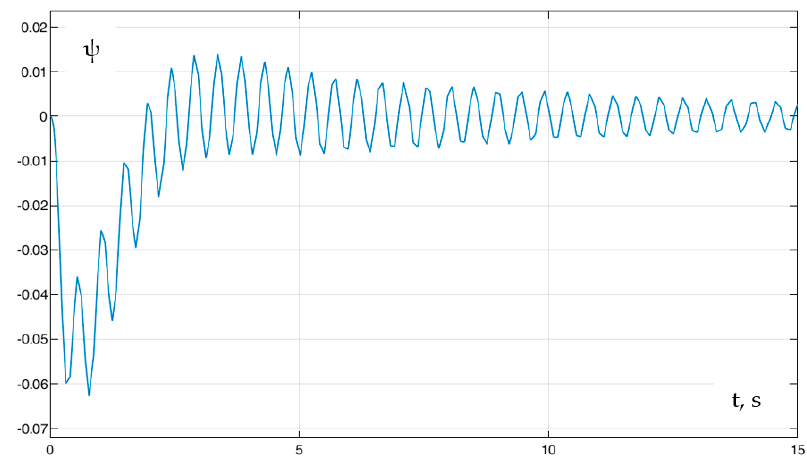
Figure 13. Simulink model of the system with the influence of elastic deformation on the object in Figure 10.